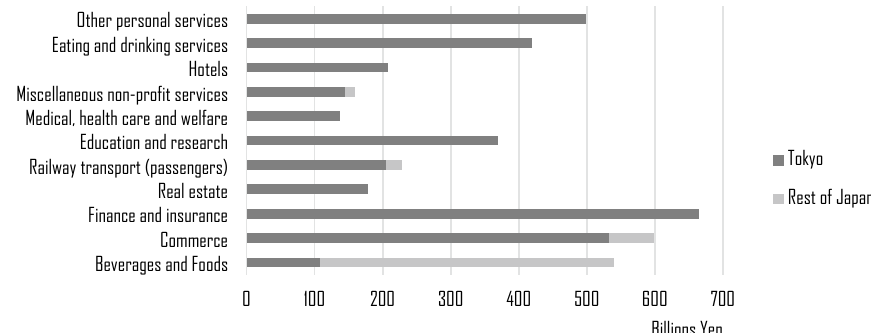
Fig. 4 Above-average visitors’ expenditure in Tokyo by regional output. Source: Tokyo